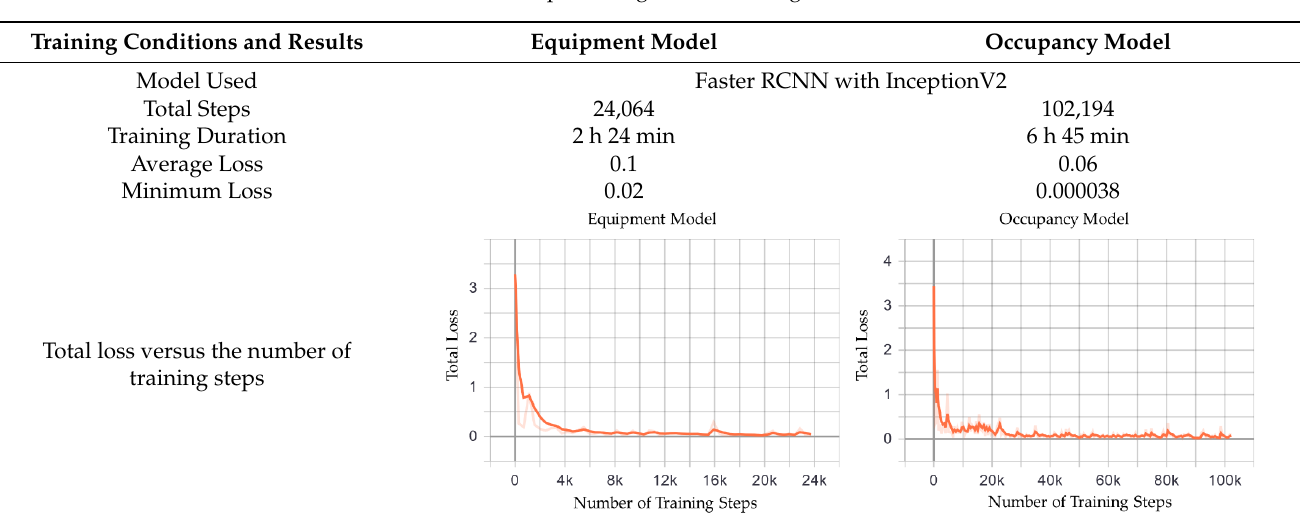
Table 5. Deep learning model training results.